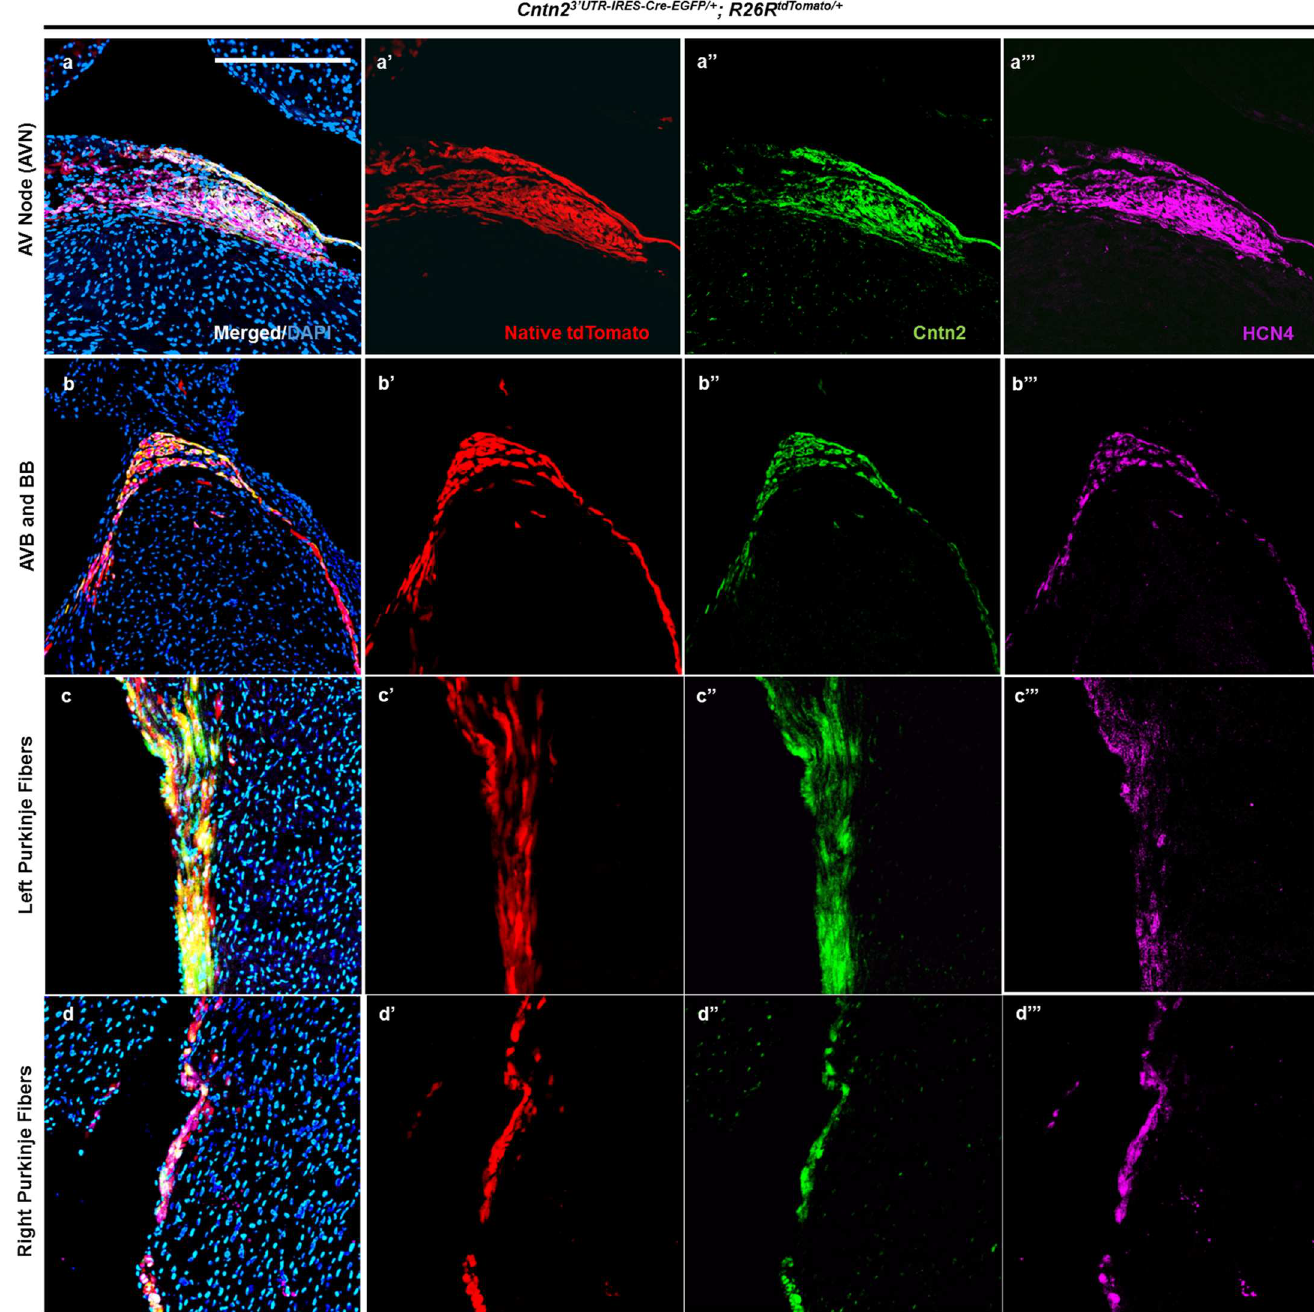
Fig 3. tdTomato co-localizes with VCS markersin Cntn2 3’UTR-IRES-Cre-EGFP/+ ; R26R tdTomato/+ mice. (a-d) Cntn2 3’UTR-IRES-Cre-EGFP/+ mice were crossed with R26R tdTomato/tdTomato reporter mice, and P42 heart cryosections were imaged by confocalmicroscopy. (a, a’, a”, a”‘) High resolution confocalimages of the AVN regiondemonstrates co-localization of tdTomato (a’, red), endogenousCntn2 (a”, green), and endogenousHcn4 (a”‘, magenta)with the merged image shown in (a). (b, b’, b”, b”‘) High specificity and completeoverlap (b: merged signal) of native tdTomato (b’, red), endogenous Cntn2 (b”, green), and endogenousHcn4 (b’”, magenta)expressionupon Cre recombination in the AVB and BB. (c, c’, c”, c”‘) Confocal images of mouse heart sectionsshowingthat Cre recombinedtdTomato cells of left PFs (c’, red) co-localizewith endogenousCntn2 (c”, green) and Hcn4 (c”‘, magenta). (d, d’, d”, d”‘) Images of serial Cntn2 3’UTR-IRES-Cre-EGFP/+ ; R26R tdTomato/+ mice heart sections verifiedco-expression of endogenous Cntn2 (d”, green) and Hcn4 (d”‘, magenta) in recombined tdTomato cells (d’, red) of right PFs. Blue signal indicatesnuclearcounterstaining with DAPI. The cardiac anatomicallocationfor each confocalmicrograph is shown in S2A Fig. Scale bar: 100 μ m.